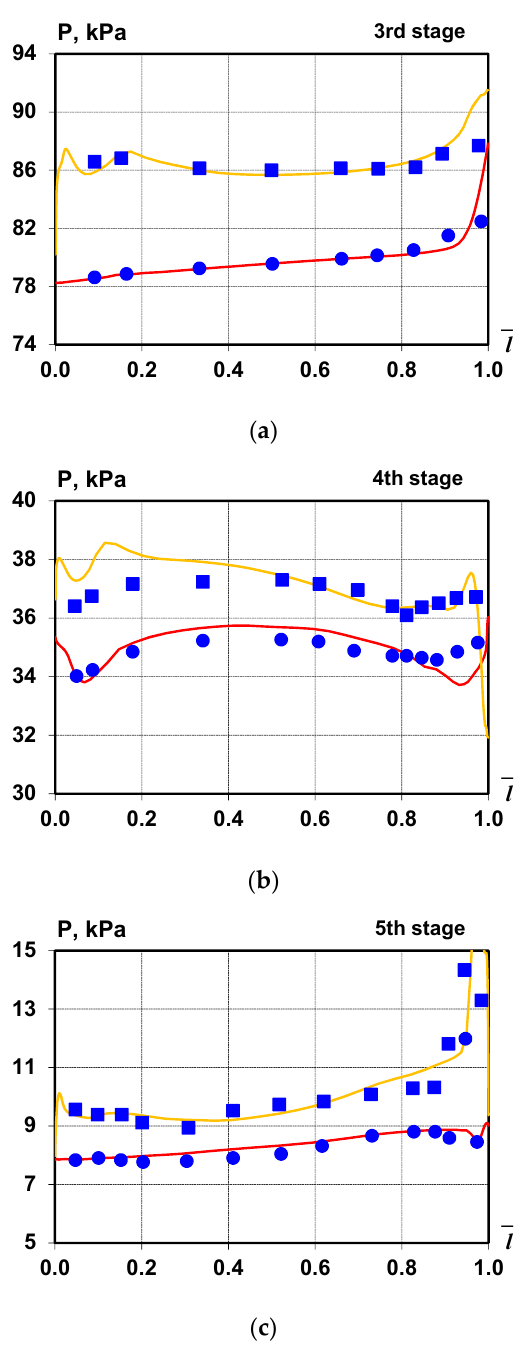
Figure 2. Total and static pressure distributions along the blade beyond the third ( a ), fourth ( b ), and fifth ( c ) stages.